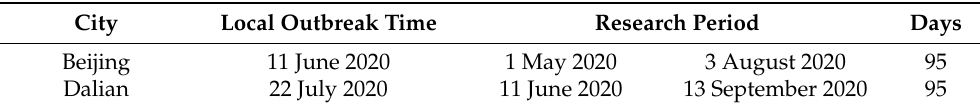
Table 1. Research